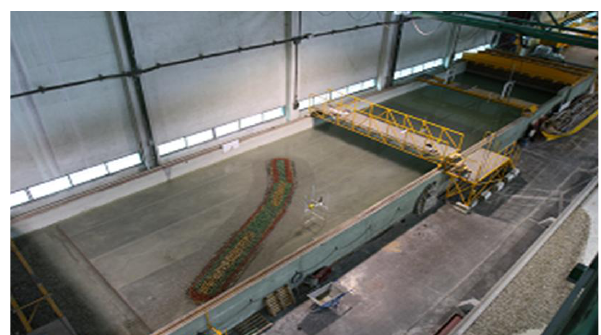
Fig. 1. Water wave tank.